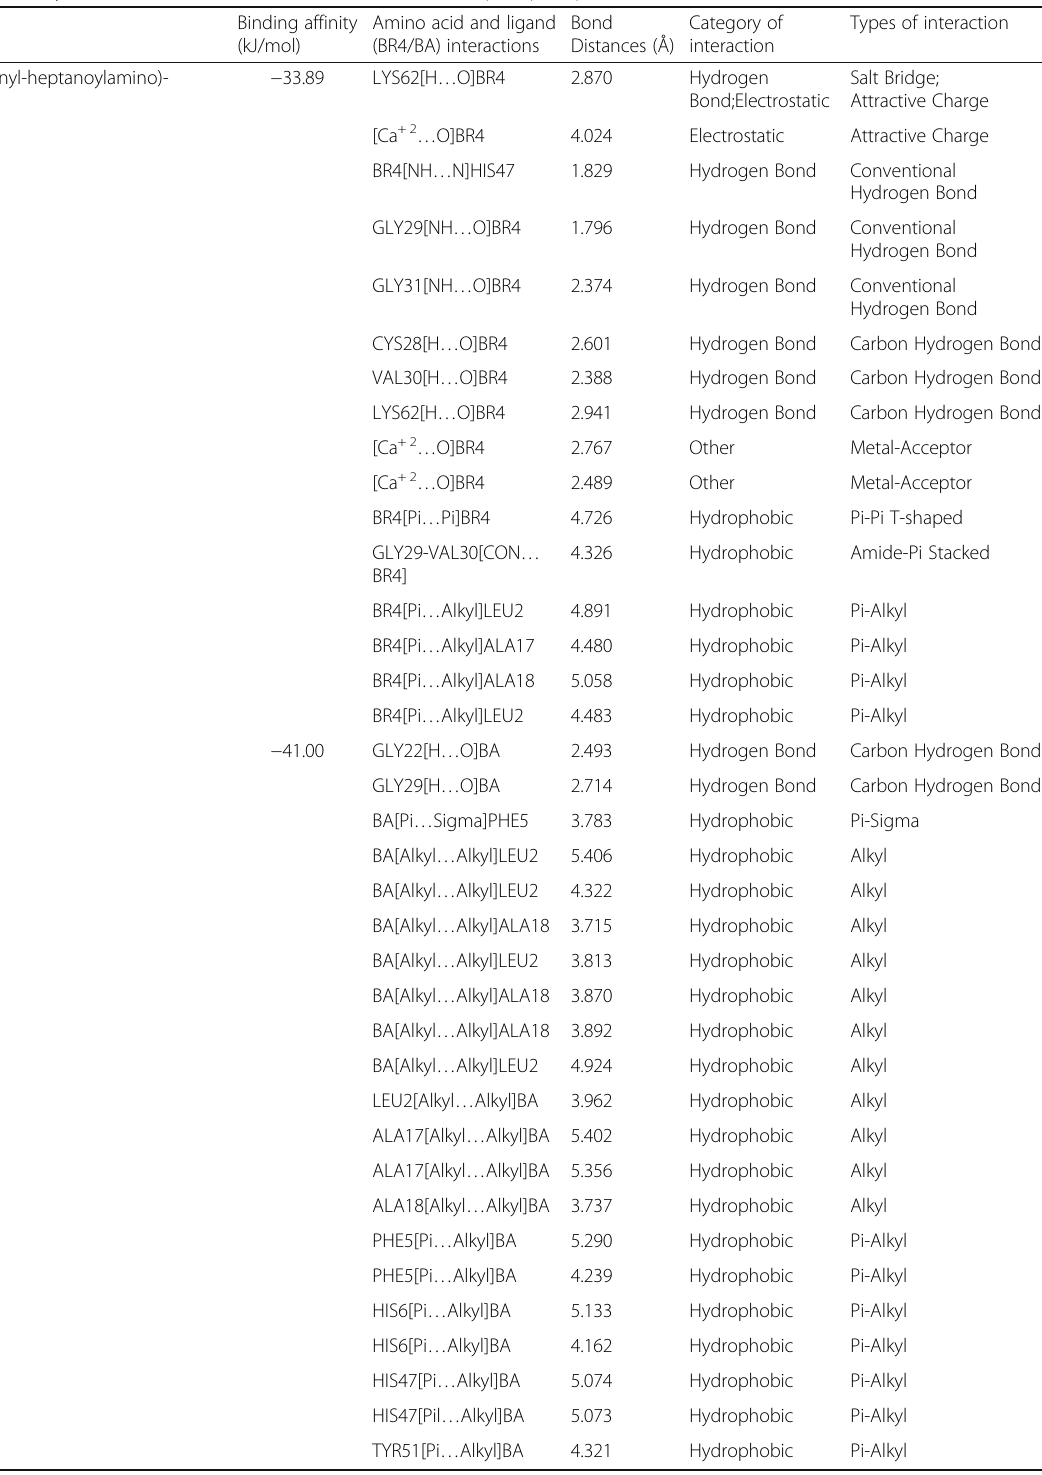
Table 10 Binding affinity (kJ/mol) and interactions of BR4 and BA with phospholipase A2 (1KQU) Compound